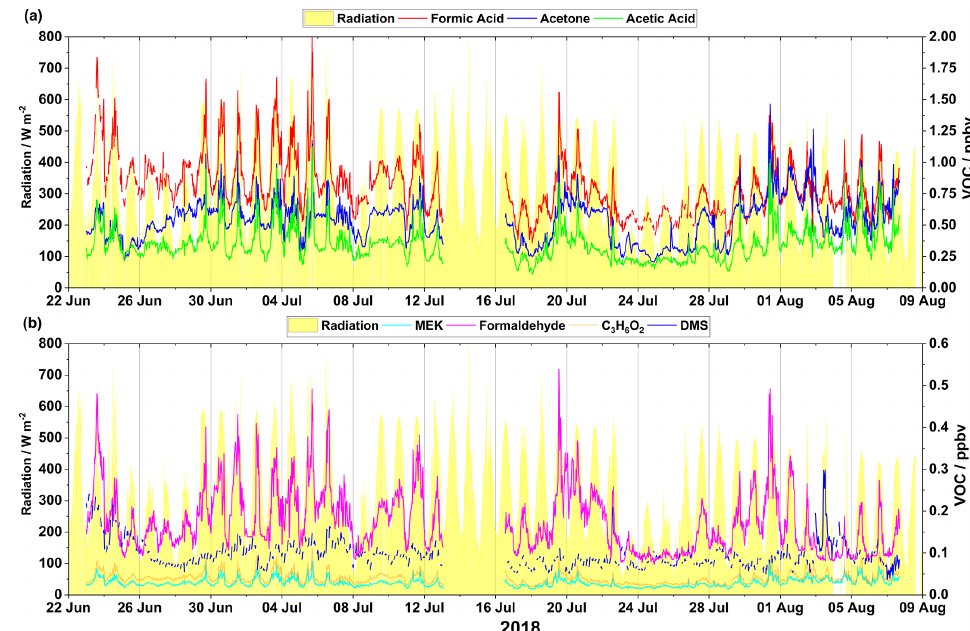
Figure 2. Time series for (a) formic acid, acetone, acetic acid, and radiation and (b) MEK, formaldehyde, C 3 H 6 O 2 , DMS, and radiation during the period 22 June–9 August displaying the diurnal profile for each species.